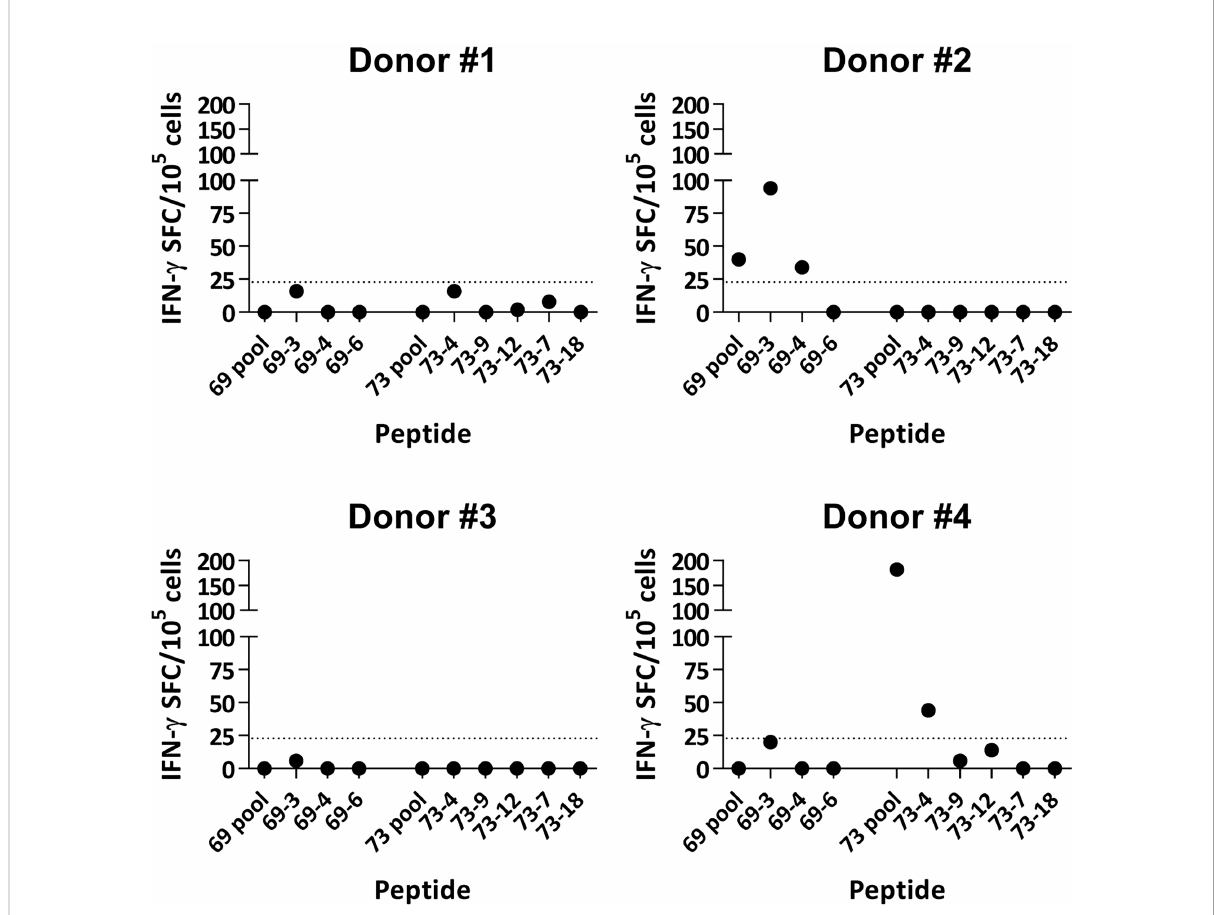
FIGURE 6 In vitro immunogenicity of TNBC neoAgs with human T cells. CD8 T cells obtained from four healthy HLA-A*02:01 + donors were stimulated in vitro with peptide-pulsed dendritic cells and expanded with IL-2. Three weeks later, T cells were harvested and peptide recognition was measured in ELISPOT assays using peptides and autologous DC. Results show recognition of peptides pools and individual peptides. Values obtained in negative control wells without antigen have been subtracted. The dotted line corresponds to the 20 SFC threshold de fi ning positive